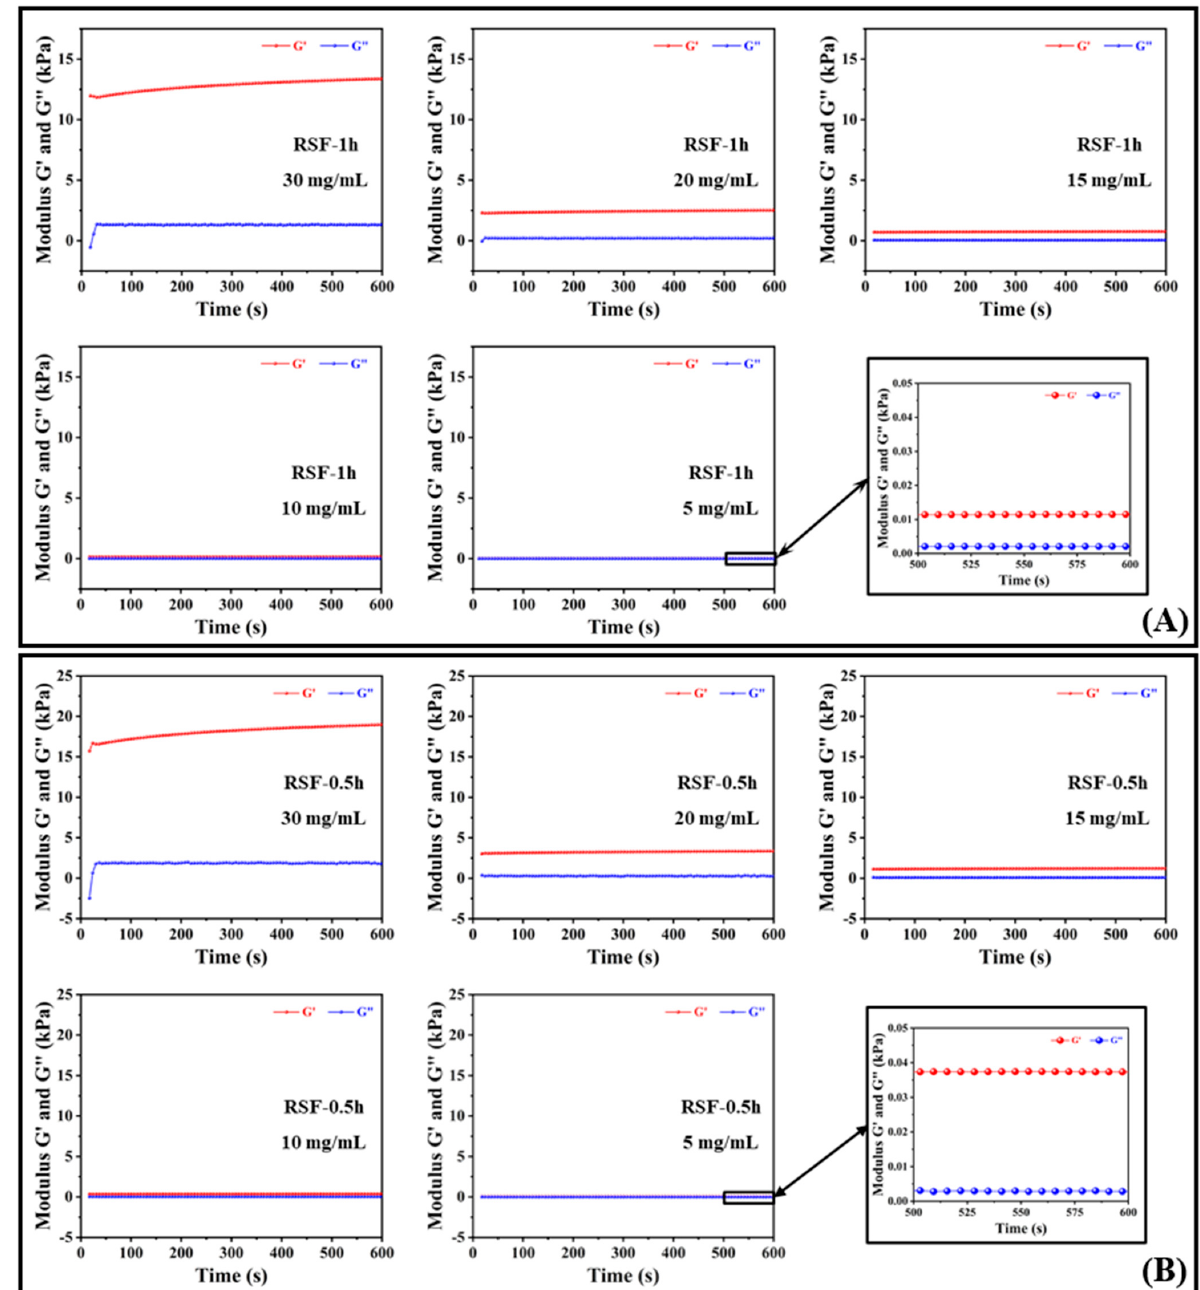
Figure 3. Rheological properties of silk fibroin hydrogels formed by silk fibroins with different Mw at 37 °C and concentrations of 30, 20, 15, 10, and 5 mg/mL. ( A ) RSF-1h; ( B ) RSF-0.5h.